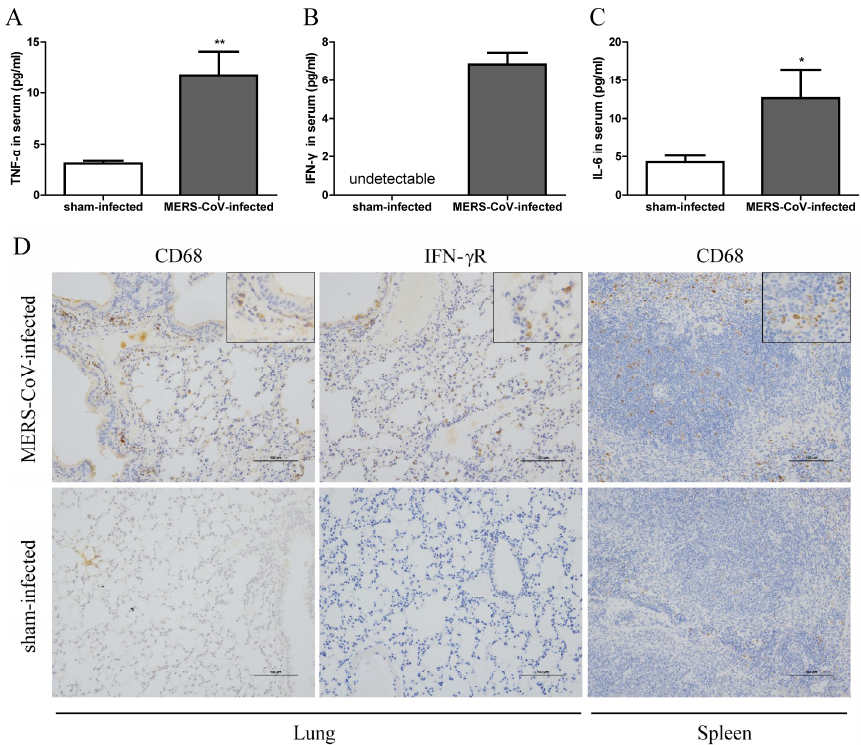
Figure 3. MERS-CoV infection induces systemic inflammation in hDPP4-transgenic mice. ( A – C ) Concentration of TNF-α, IFN-γ, and IL-6 in serum at Day 3 post-MERS-CoV infection. Data are expressed as means ± SEM (n = 5–6 per group). * p < 0.05, ** p < 0.01 (Student’s t test with Welch’s correction). ( D ) Macrophage infiltration and expression of IFN-γ receptor were assessed by immunohistochemical staining of lung and spleen at 7 days post-challenge (scale bars = 100 μm).